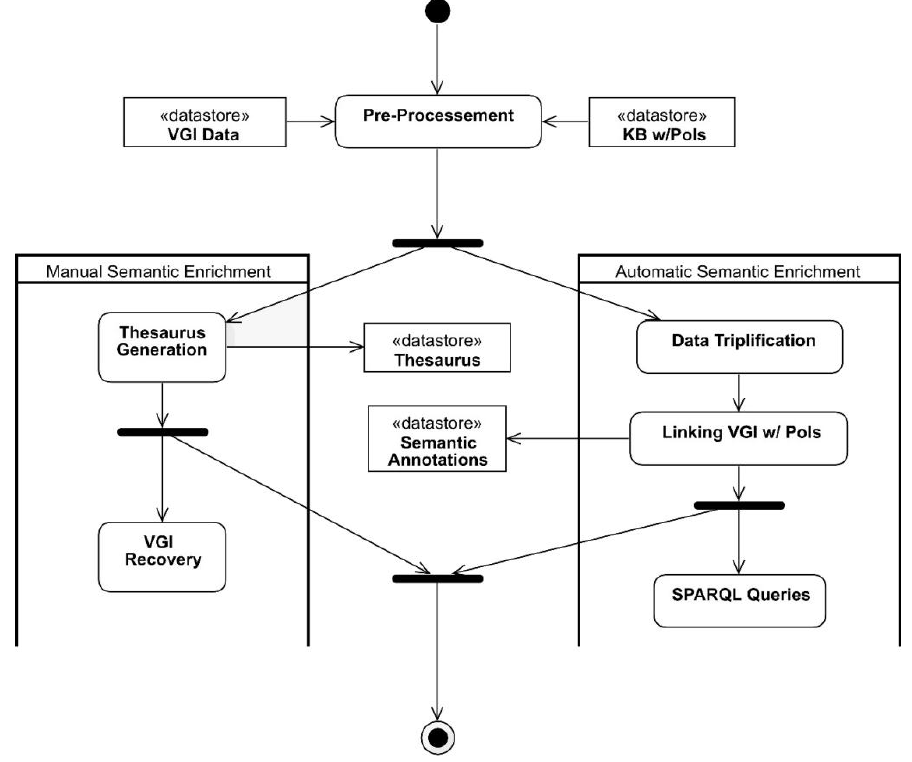
Figure 1. Flowchart of the volunteered geographic information (VGI) semantic enrichment process